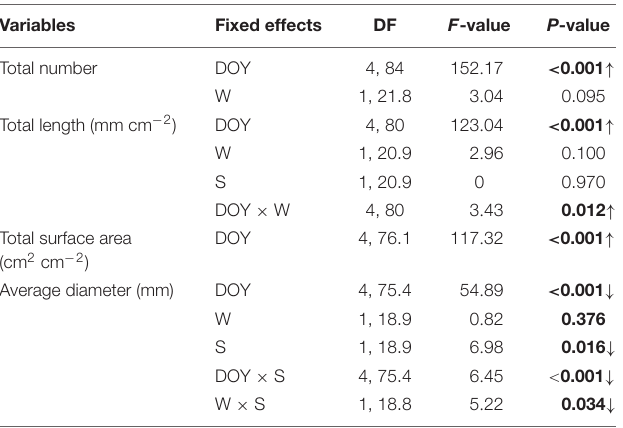
TABLE 3 | P -values of treatment effects on root parameters over the measurement season 2014 (ANOVA repeated mixed model). Variables